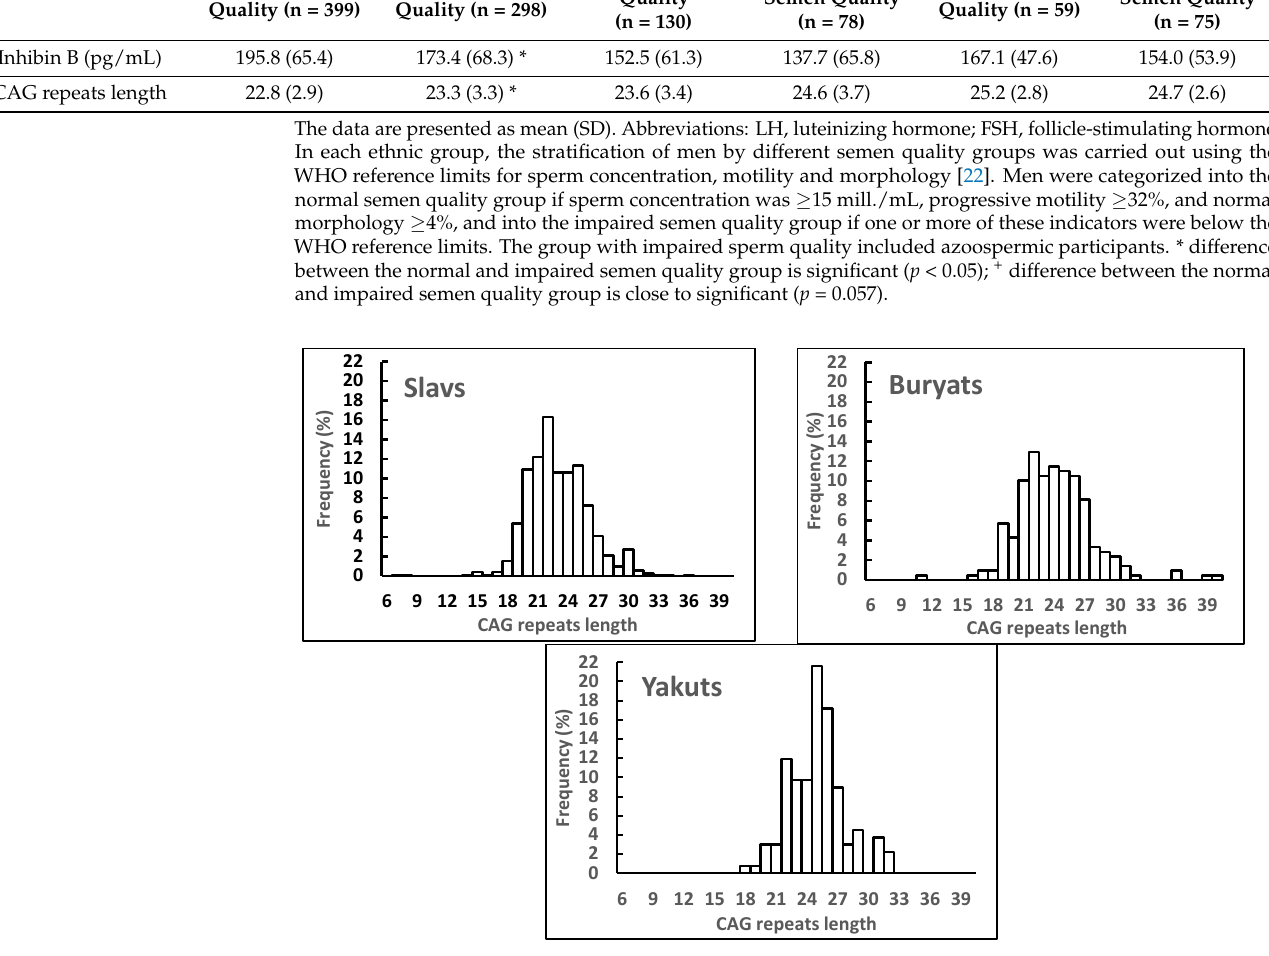
Figure 2. Frequency distribution of the CAG repeat length in the Slavic, Buryat and Yakut ethnic subgroups. Values are given as percentage of cases in relation to the respective number of men in each ethnic group.